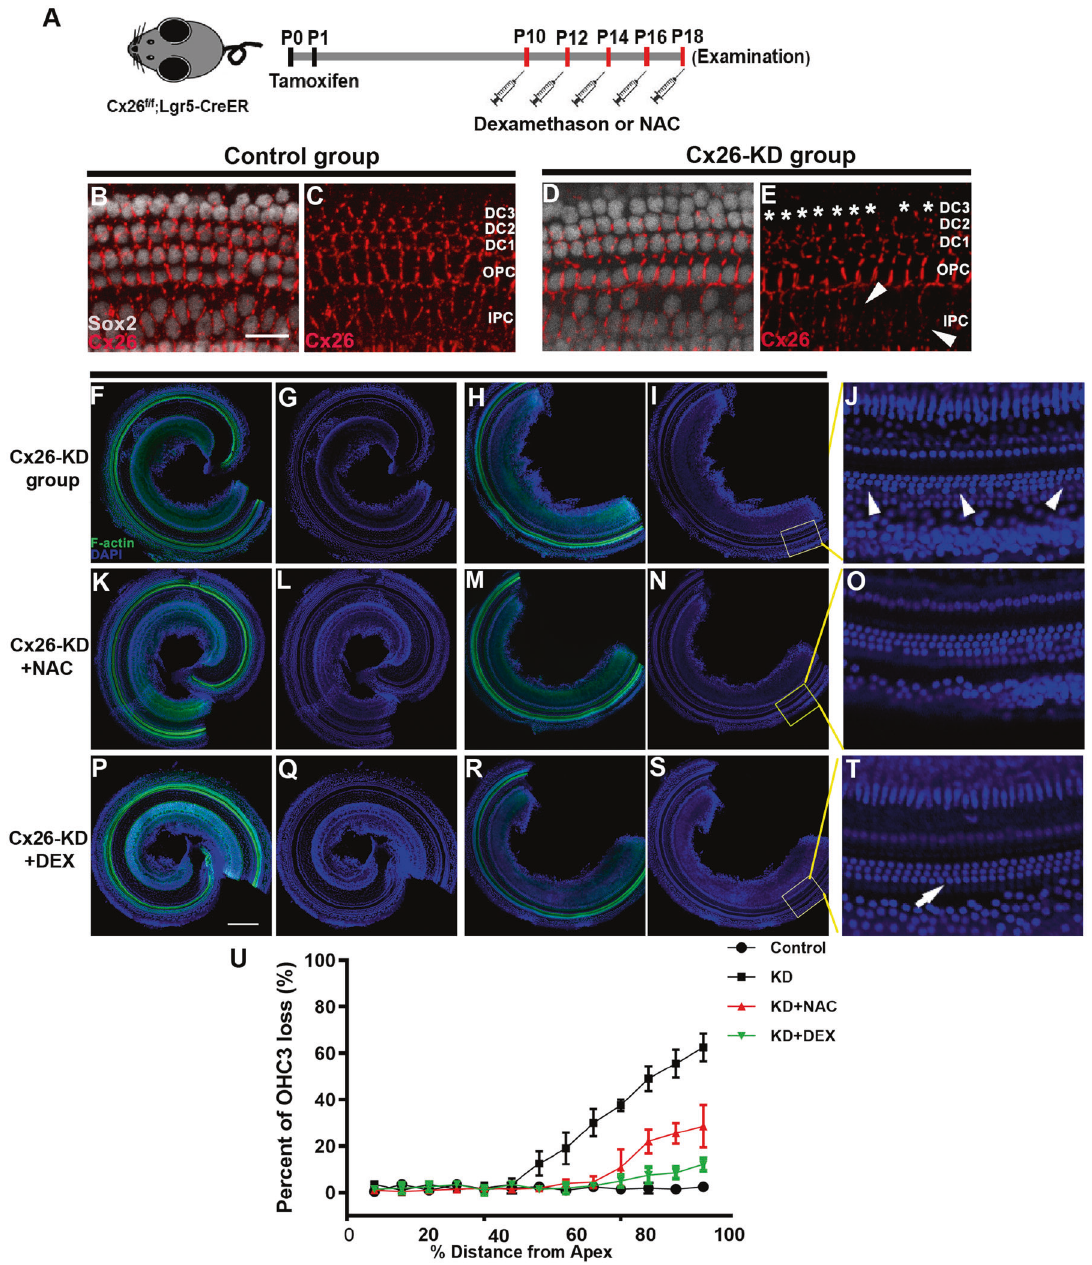
Fig. 3 Effects of DEX or NAC on the degeneration of outer hair cell in speci fi c longitudinally Cx26-null mice. A Schematic of the experimental work fl ow, Cx26 f/f ; Lgr5CreER mice were injected with TMX and then treated with dexamethasone 5 mg /kg or NAC 300 mg /kg for fi ve days. B , C Cx26 immunolabeling (red) in the apical of the control group. D , E Cx26 immunolabeling (red) in the apical of the speci fi c longitudinally Cx26-null group. The asterisk indicates that Cx26 of the third row DCs was successfully knocked out. F – I Representative images of the fl attened cochlear preparations in speci fi c longitudinally Cx26-null group. J Magni fi cations of the yellow box in the panel ( I ), the white arrowheads in panel J indicated the OHC3 loss. K – N Representative images of the fl attened cochlear preparations in Cx26-null + NAC group. O Magni fi cations of the yellow box in the panel ( N ). P – S Representative images of the fl attened cochlear preparations in Cx26-null + DEX group. T Magni fi cations of the yellow box in the panel ( S ). U Quanti fi cations of OHC3 loss in the different groups. Scales in panels ( B ) and ( K ) represent 40 and 200 μ m,